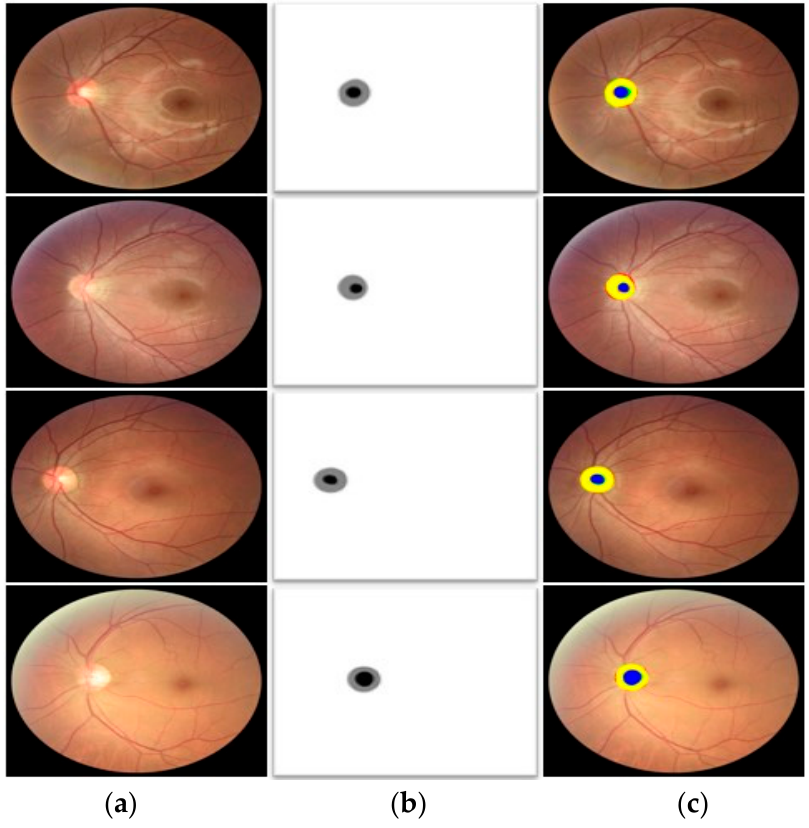
Figure 6. Good OC and OD segmentation qualitative results on the REFUGE database, attained by applying FEDS-Net. ( a ) Input image, ( b ) corresponding groundtruth image, and ( c ) segmented output images (tp pixels for OD and OC are indicated in yellow and blue, respectively. Likewise, red and green show fn and fp pixels, respectively).